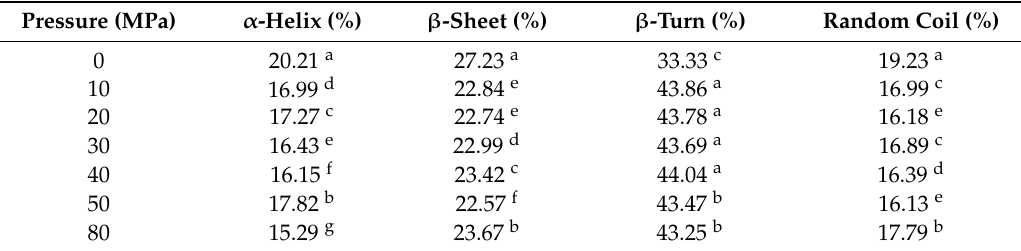
Table 2. Effects of HPH treatment on secondary structure composition of